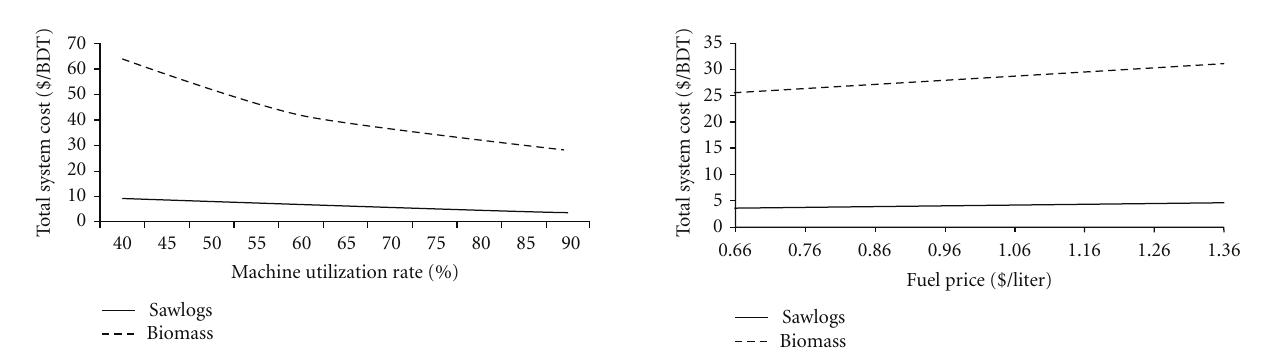
Figure 5: Total system cost for producing biomass in an integrated harvesting system based on varying machine utilization rates.